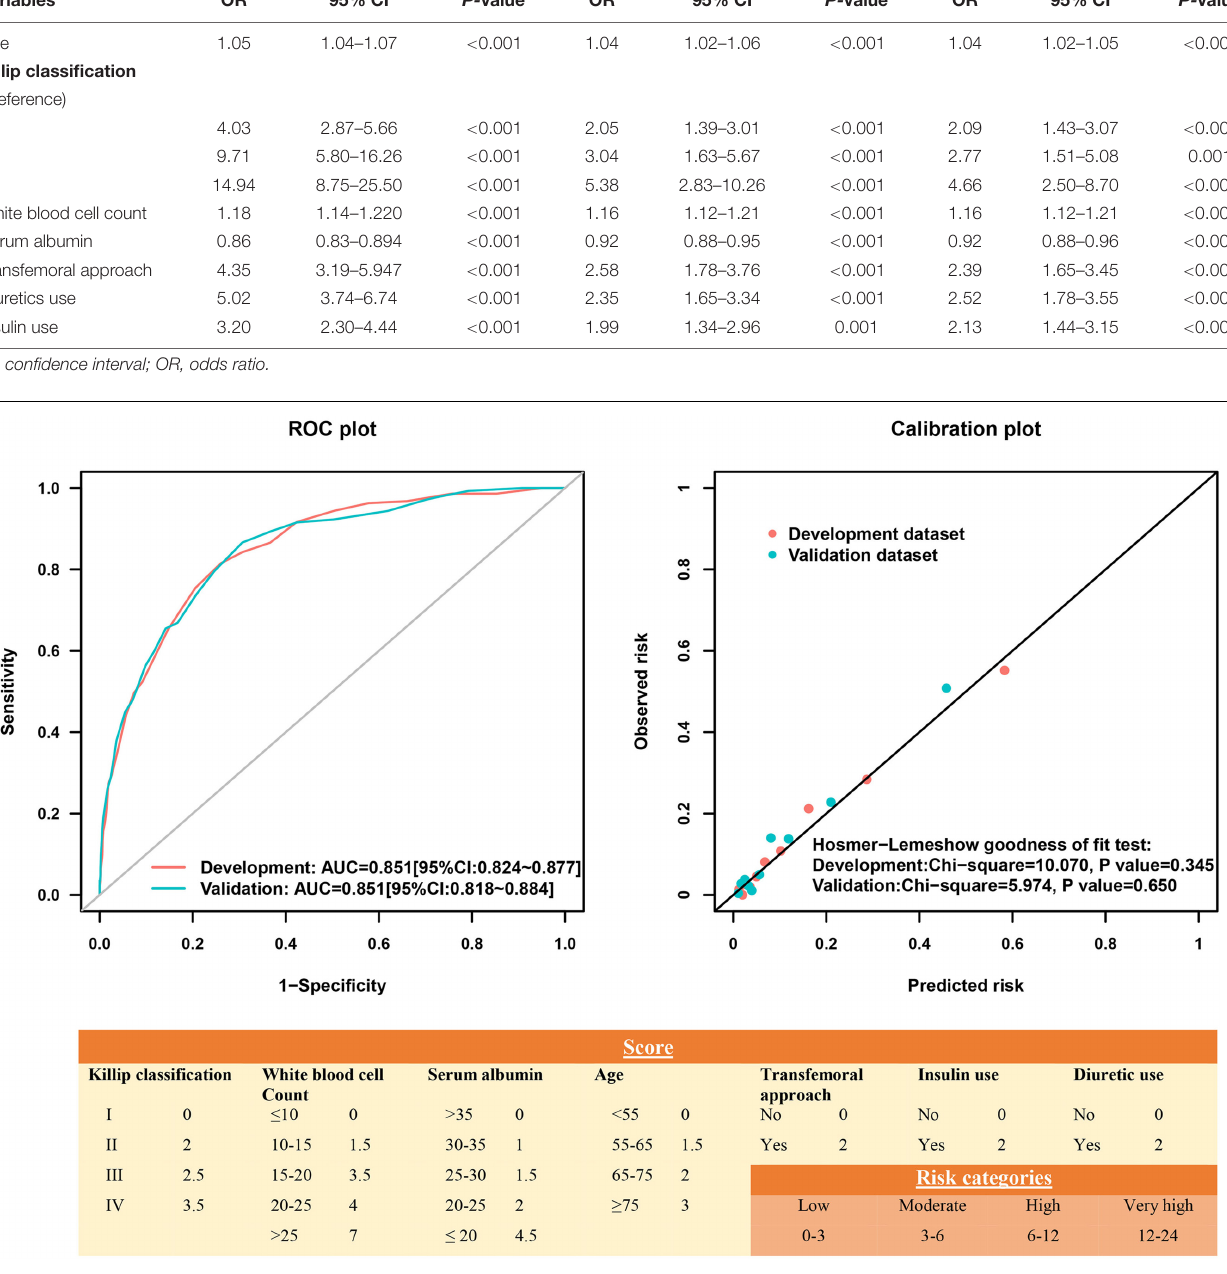
IABP ( Supplementary Table 5 ). Besides, subgroup analyses including age, gender, anemia, diabetes, and chronic